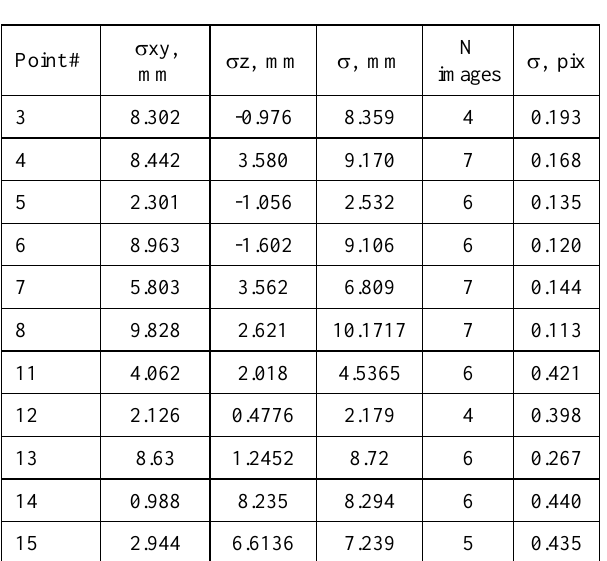
Table 5. Measurements precision (control points)